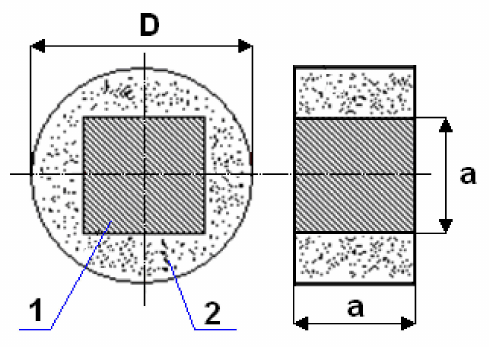
Figure 2. Diagram of the measuring cell: 1—porous material; 2—sealing material (cubic sample); D = 49 mm; a = 20